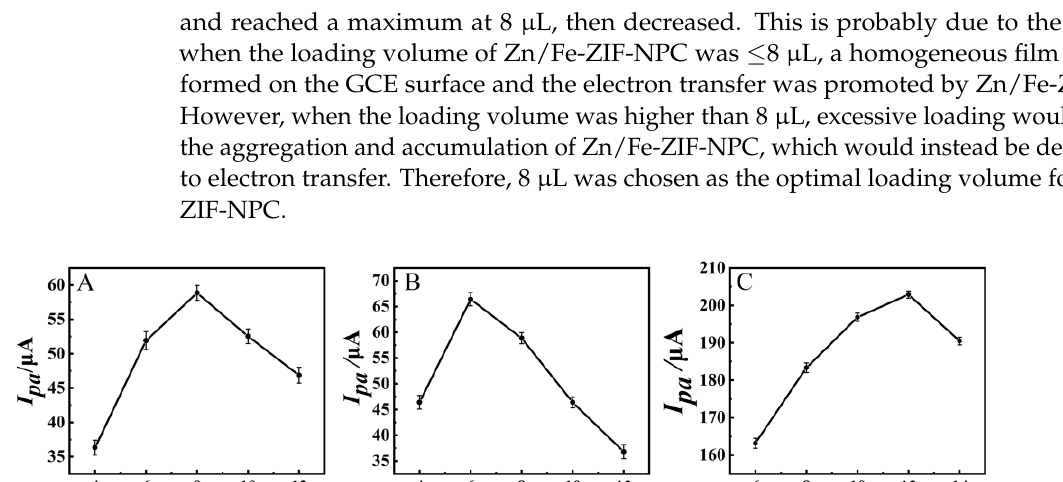
Figure 9. ( A ) Effects of immobilization time of aptamer on I pa , ( B ) Effects of aptamer concentration on I pa , ( C ) Effects of PQ incubation time on ФI . Error bars were obtained as the standard deviation of triple measurements ( n = 3).